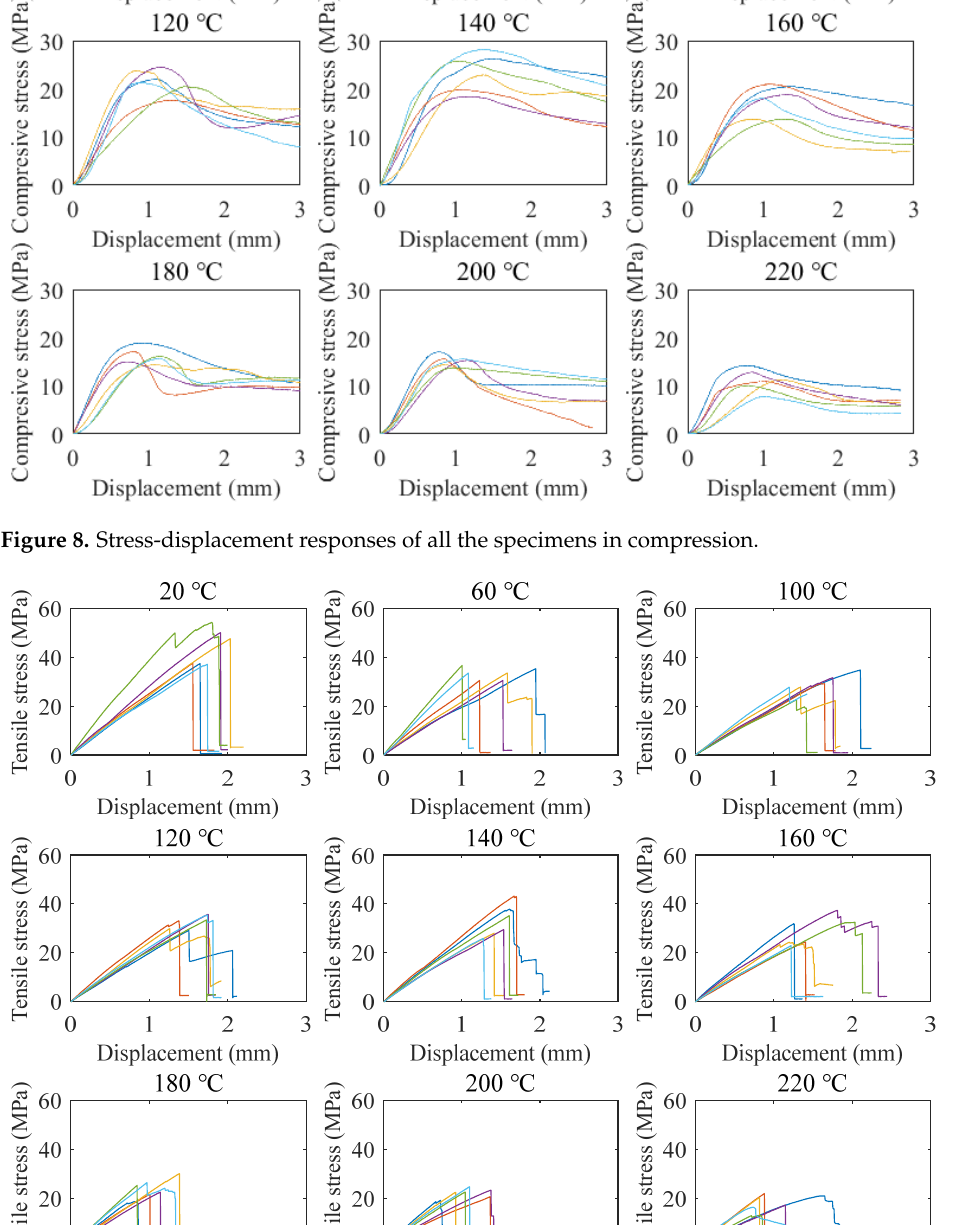
Figure 10. Typical stress-displacement curves: (a) compression and (b) tension. 3.5. Temperature-dependent strengths and deformations